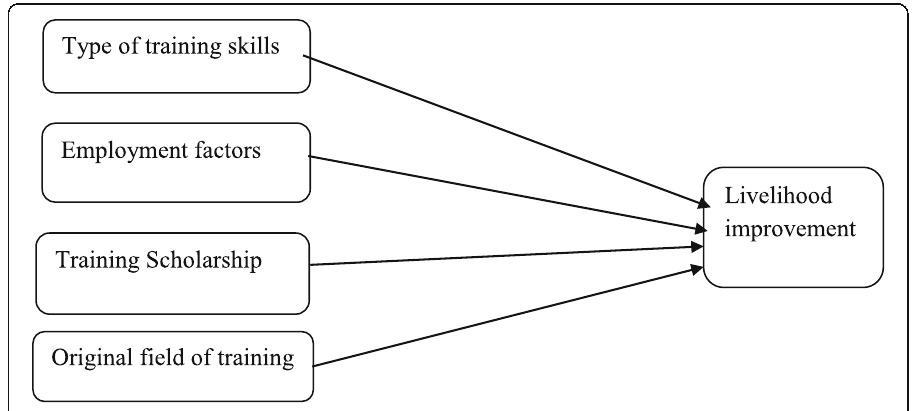
Fig. 1 Conceptual framework. Source: Compiled from a literature